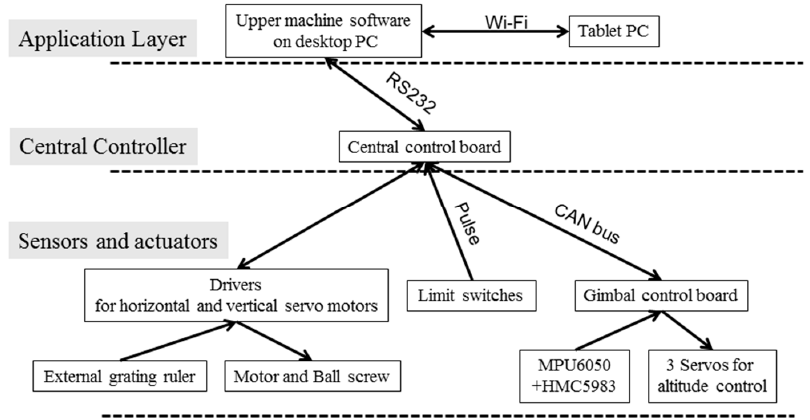
Figure 2. Illustration of the system structure.